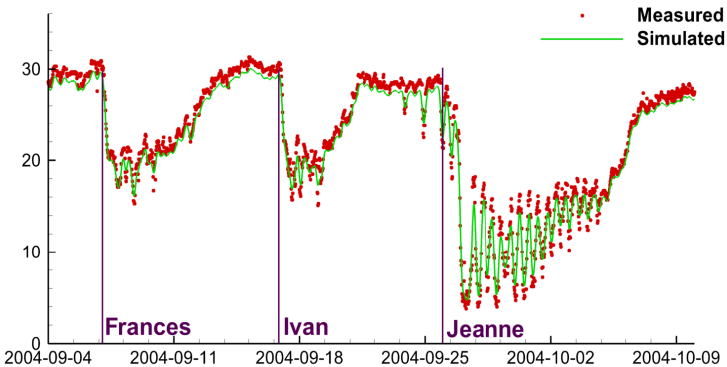
Figure 6. Salinity before, during and after Hurricanes Frances, Ivan and Jeanne at Cat Point station.